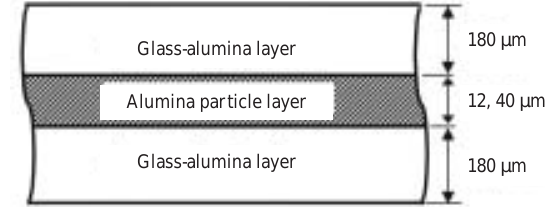
Schematic drawing of layer structure of substrate before